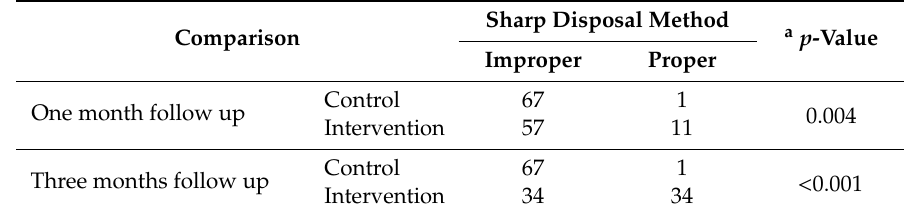
Table 6. Comparison in proportion of proper community sharp disposal method between control and intervention group at one month and three months follow up, using ITT approach ( n = 136). Sharp Disposal Method a p -Value Comparison Improper Proper Control 67 1 One month follow up 0.004 Intervention 57 11 Control 67 1 < Three months follow up 0.001 Intervention 34 34 a Fisher’s exact